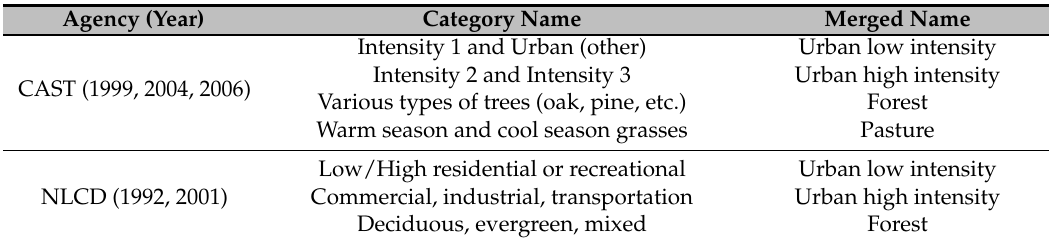
Table 2. Land-use and land-cover merged categories for the Center for Advanced Spatial Technologies (CAST) and National Land Cover Datasets (NLCD) layers (Reproduced from Pai and Saraswat [27]).